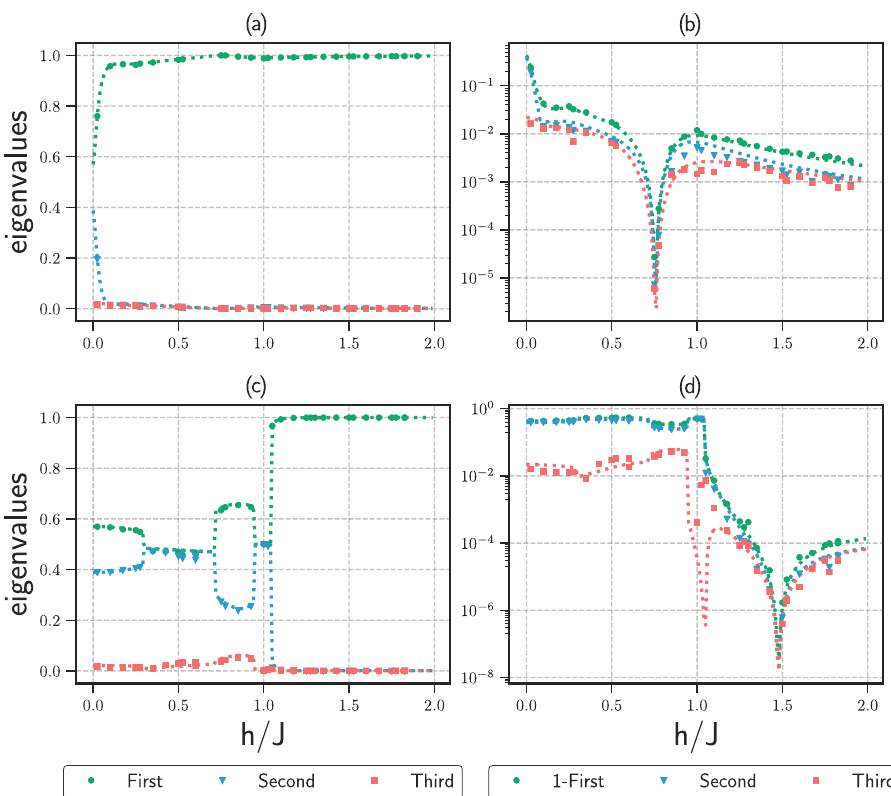
Fig. 7 Exact and estimated eigenvalues versus fi eld value, for the VQSE entanglement spectroscopy implementations. The input state ρ is given as the reduced state of 4 neighboring qubits from the ground state of (19). Top and bottom rows correspond to ferromagnetic and antiferromagnetic couplings, respectively. Dashed curves represent the exact three largest eigenvalues of ρ , while plot markers indicate the VQSE estimated eigenvalues. In a and c we see that VQSE can accurately estimate the eigenvalues. In b and d we plot 1 − λ 1 , and the y axis is on a log scale. Here we see that the quantum critical factorization points are detected at h / J x ≈ 0.76 and h / J x ≈ 1.43 in ( b ) and ( d ), respectively, e λ e λ ; e λ since at those points we have 1 (cid:7) 1 , and 2 3 (cid:7) 0